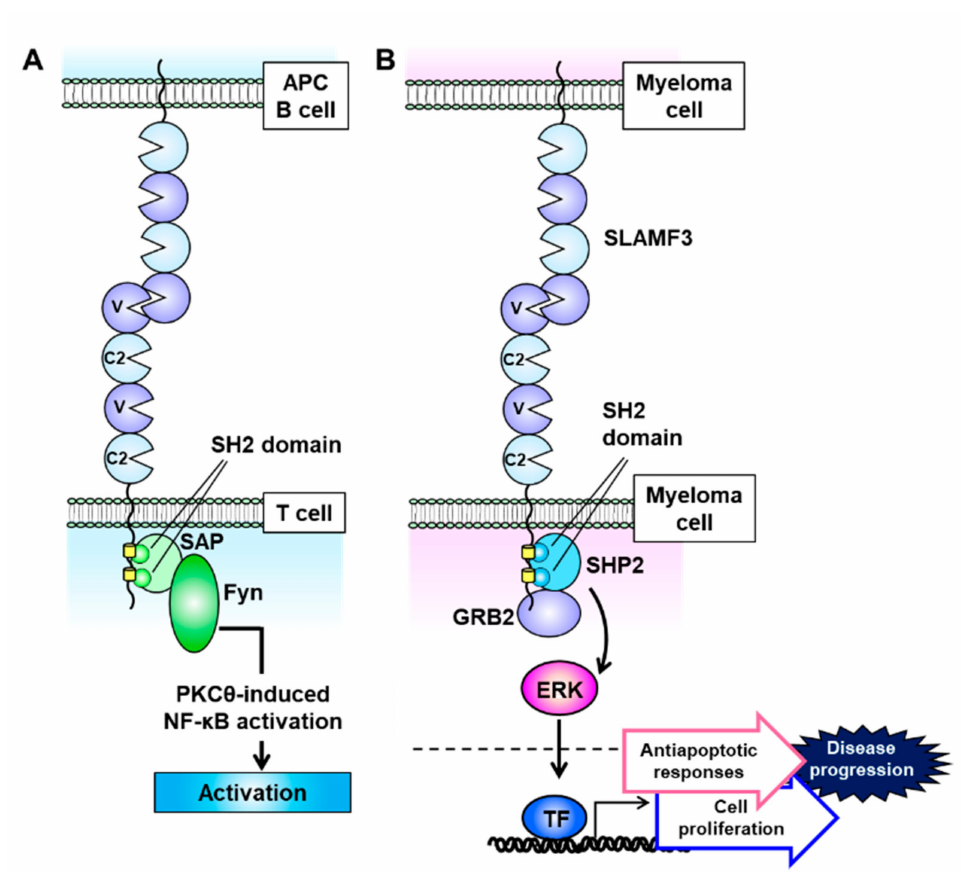
Figure 3. Signaling lymphocytic activation molecule family receptor (SLAMF) 3 signal transduction is mediated via self- ligation and cell–cell interactions. ( A ) SLAMF3 recruits SAP at two immunoreceptor tyrosine-based switch motif (ITSM) domains, and the SLAM–SAP–Fyn signaling pathway promotes T cell activation. ( B ) On multiple myeloma (MM) cells, SLAMF3 activates the ERK signal transduction pathway. This function is mediated via self-ligand interactions between MM cells and SHP2 and GRB2 formation, which accelerates cell proliferation and antiapoptotic signaling to increase the malignant potential of